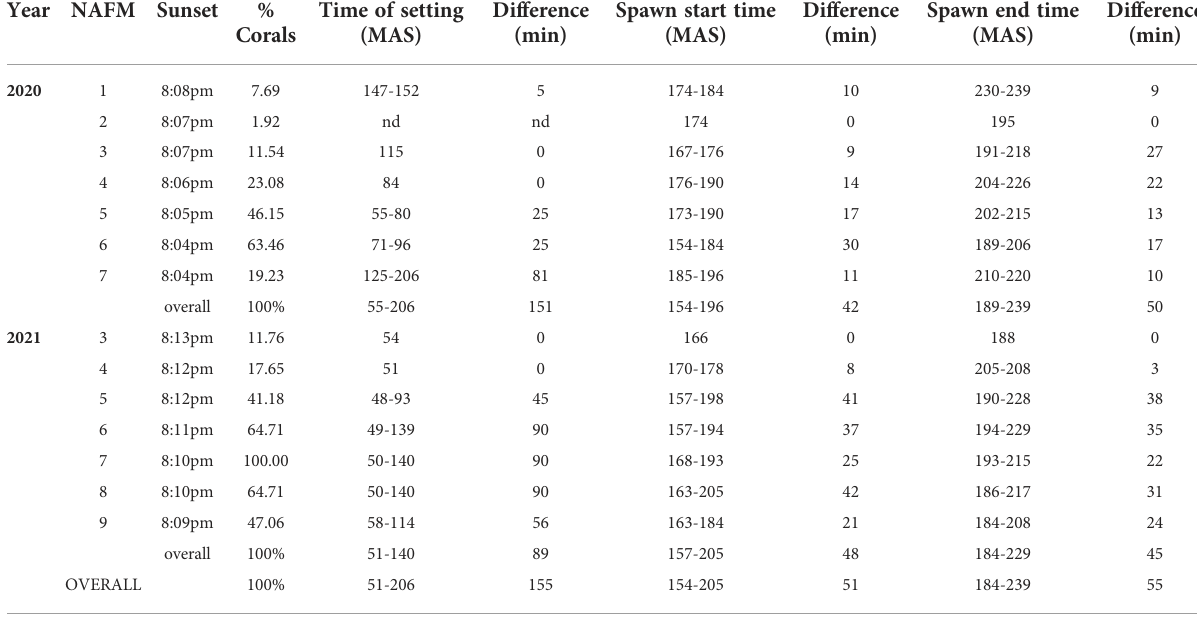
TABLE 1 Spawn timing data for 2020 and 2021 A. cervicornis broadcast spawning events. Year NAFM